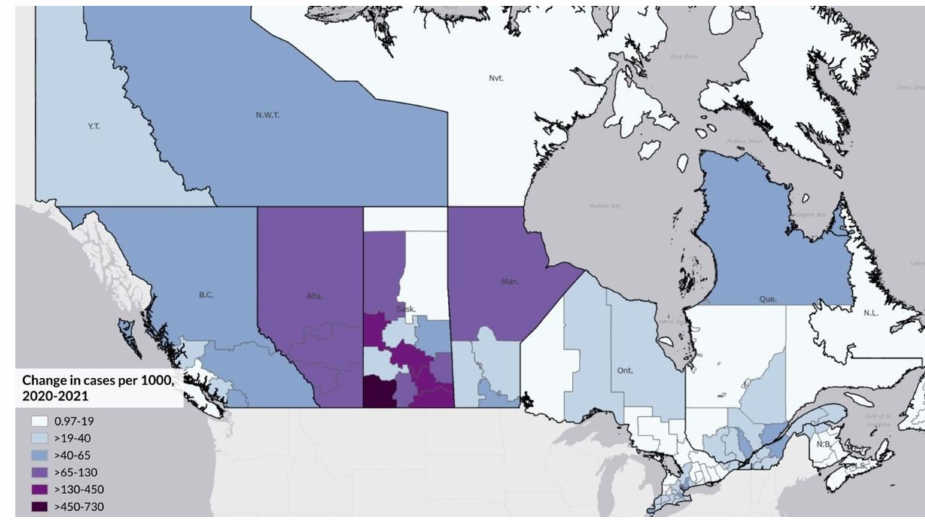
Figure 4. Changes in Logged COVID-19 Cases per 1000 by Canadian Health Region,